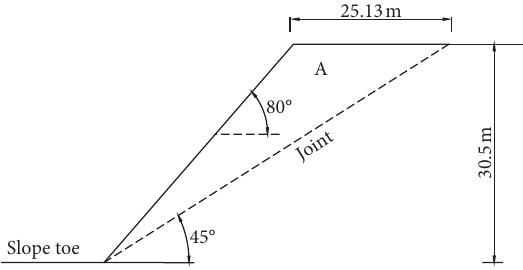
Figure 1: Simplified model of a rockslide along